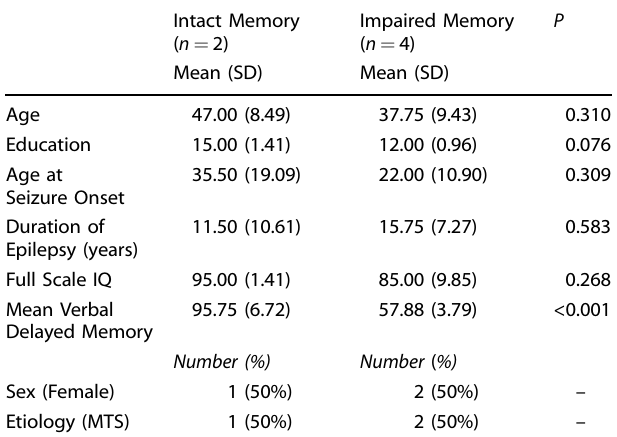
Table 1. Demographic and epilepsy-related data for study patients.